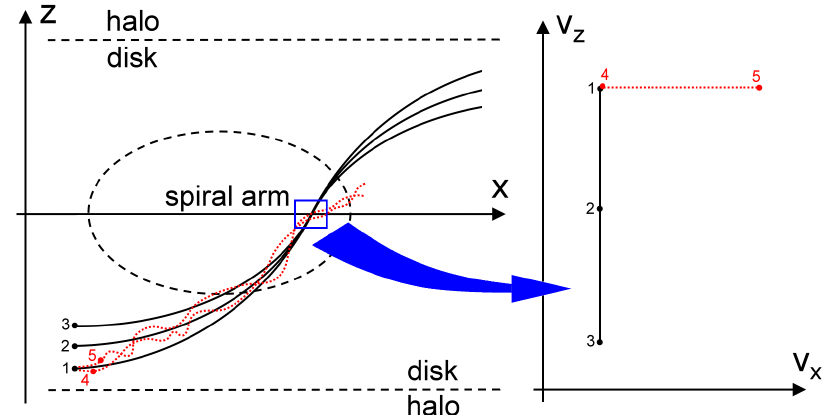
Figure 6. A schematic representation of the formation of quasi-one-dimensional structures in the velocity space for large particles. Left: trajectories of particles in a gas disk converging into the same cell. Right: the states of motion of the same particles in this